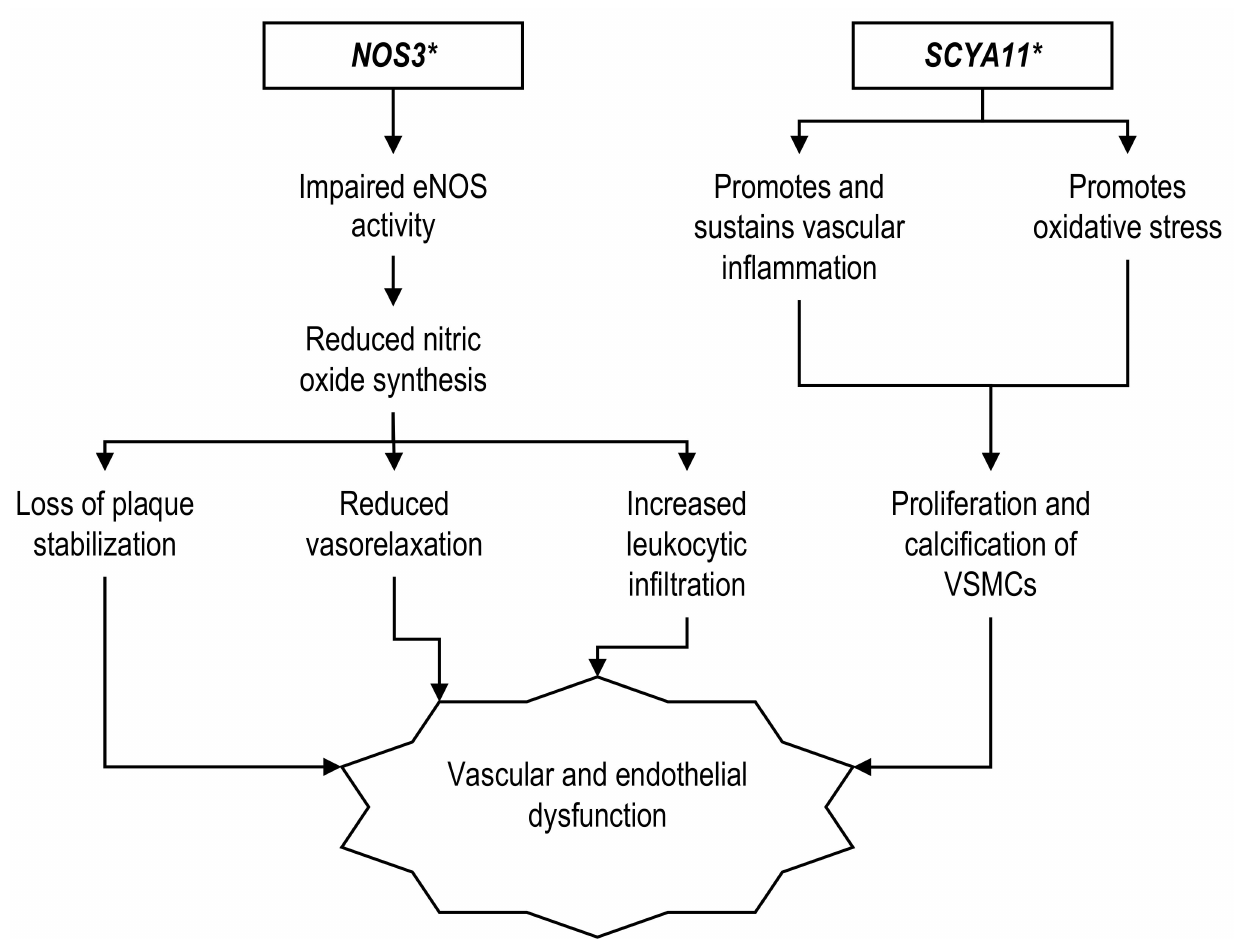
Figure 2. Proposed mechanisms of genes related to vascular and endothelial pathology associated with CHD in the T2D Asian population. * Significant association with CHD exclusive in T2D Asians but not T2D Caucasians. Abbreviations: eNOS (endothelial nitric oxide synthase), VSMCs (vascular smooth muscle